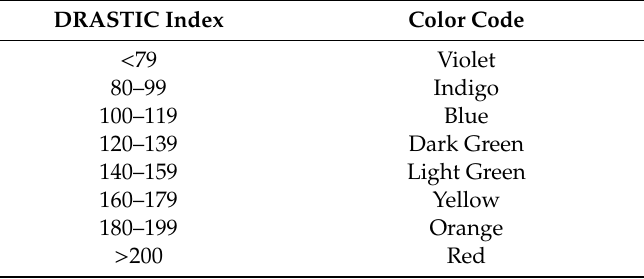
Table A2. Color codes for the DRASTIC